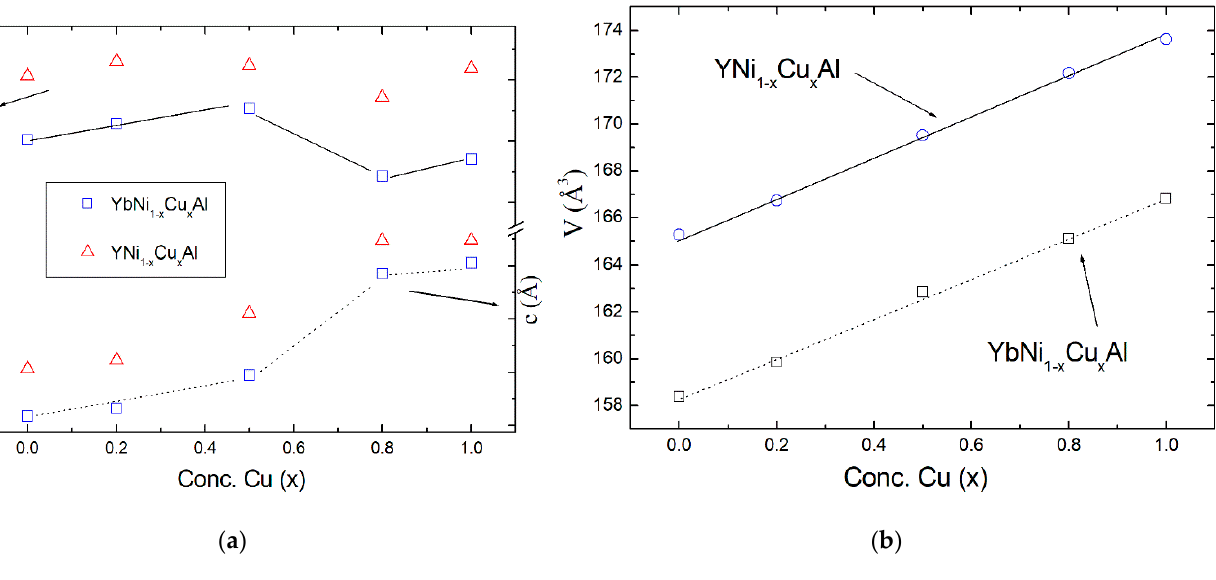
Figure 3. ( a ) Lattice a, c parameters vs. Cu concentration (x) in the series of YbNi 1-x Cu x Al and reference YNi 1-x Cu x Al compounds. There is an abrupt deviation from the linear behavior between x = 0.5 and 0.8. ( b ) Unit cell volume vs. Cu concentration (x) variation following a linear behavior. Error bars (not indicated) are within the size of data points (see Tables 1 and 2).